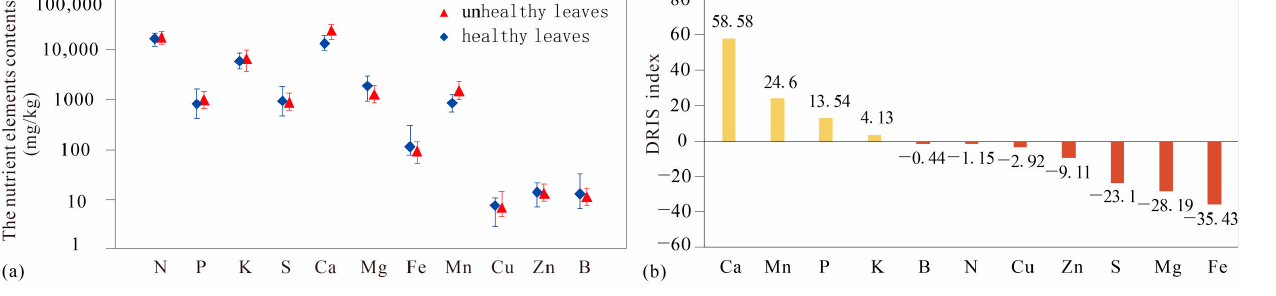
Figure 2. ( a ) The nutrient elements contents of the unhealthy leaves in the karst areas and healthy leaves in the non-karst areas; ( b ) The Diagnosis and Recommendation Integrated System (DRIS) nutritional diagnosis: yellow represents excess and red represents deficiency; the bar chart shows the abundance and deficiency of the nutrient elements in the unhealthy leaves compared to the healthy leaves.